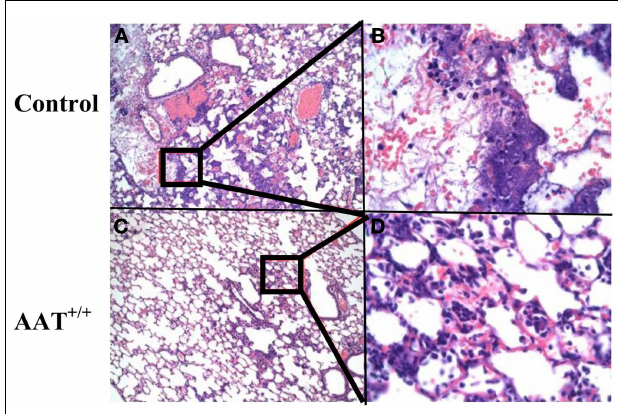
FIGURE 2 | Less inflammation in lungs ofAAT transgenic mice infected with P.aer . Six transgenic (AAT + / + ) mice and five C57Bl/6 non-transgenic control (Control) mice were infected with inhaled P.aer .Twenty-four hours after infection the mice were euthanized and lungs excised, fixed, sectioned, and stained with H&E. Representative photomicrographs of lung tissues are shown, with control lung sections in (A,B) , and AAT + / + lung sections in (C,D) . Inset regions (B,D) are magnified views of the areas indicated in black rectangles in (A,C) , respectively. (B,D) show perivascular cuffing with predominant mononuclear infiltration that is common in bacterial pneumonia. Magnification is 20 × for (A,C) and 200 × for (B,D) .